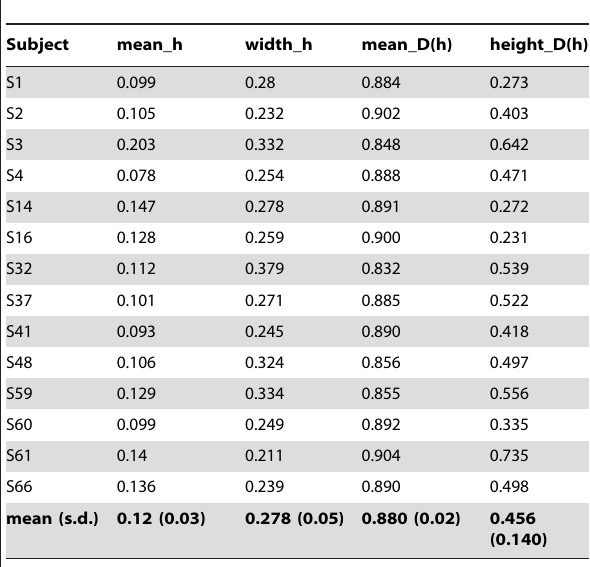
Table 2. Individual subject data for 8 min waking EEG MF- DFA